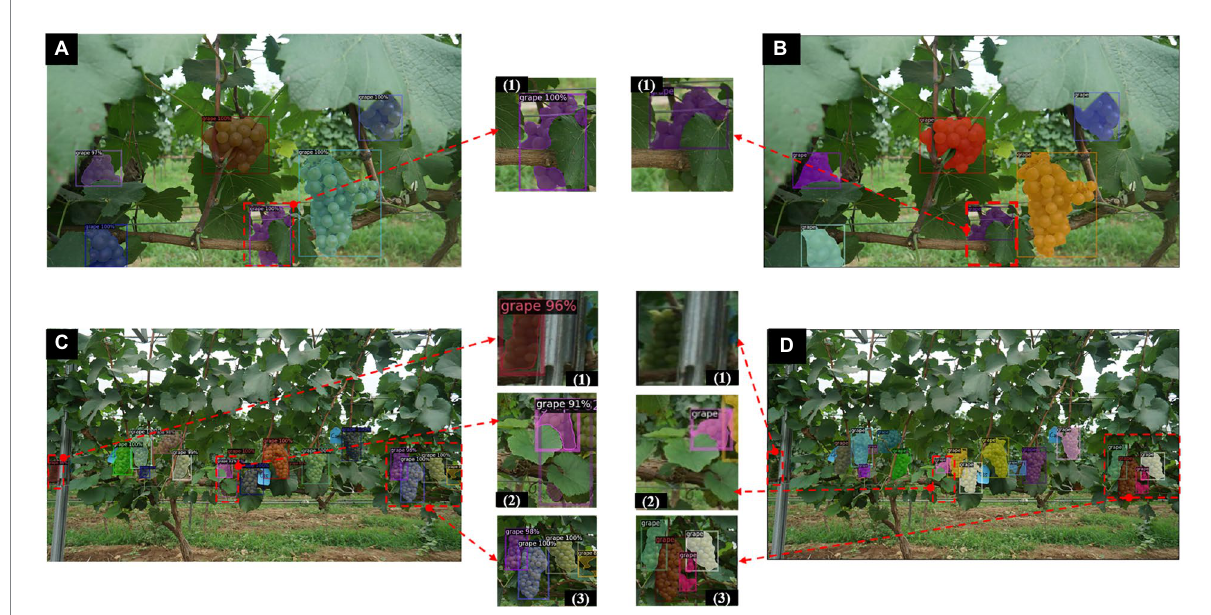
FIGURE 9 Instance segmentation results of the improved Mask R-CNN on two different types of test datasets. (A) Several image segmentation results of improved Mask R-CNN in Grape-A dataset. (B) Ground truth for several images in the Grape-A dataset. (C) Several image segmentation results of